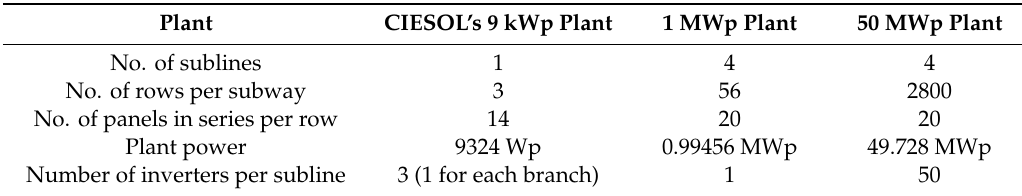
Table 1. Plant configuration.